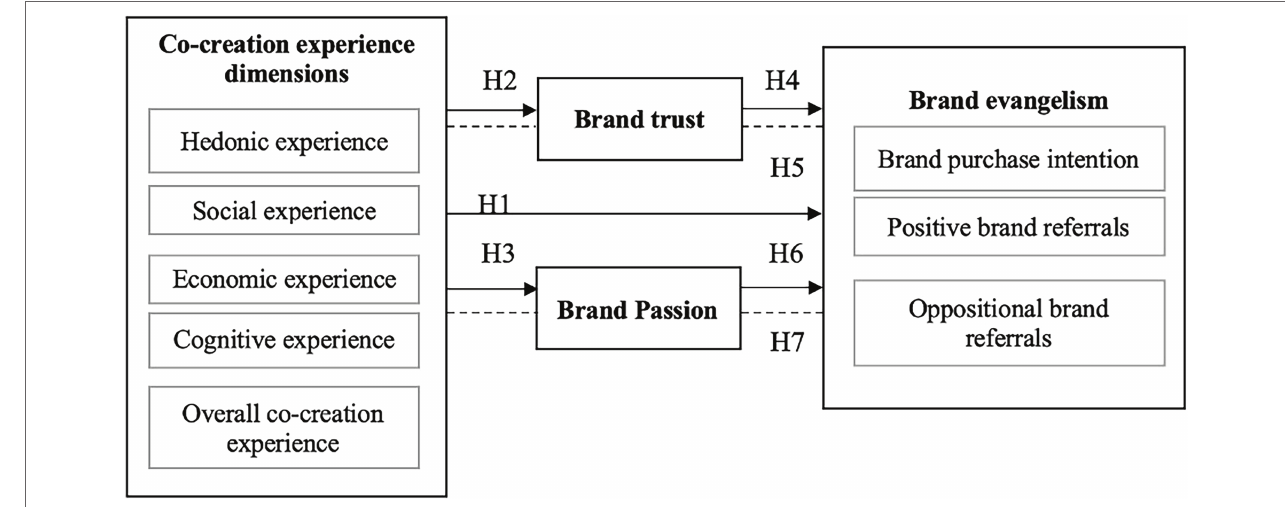
FIGURE 1 | Theoretical